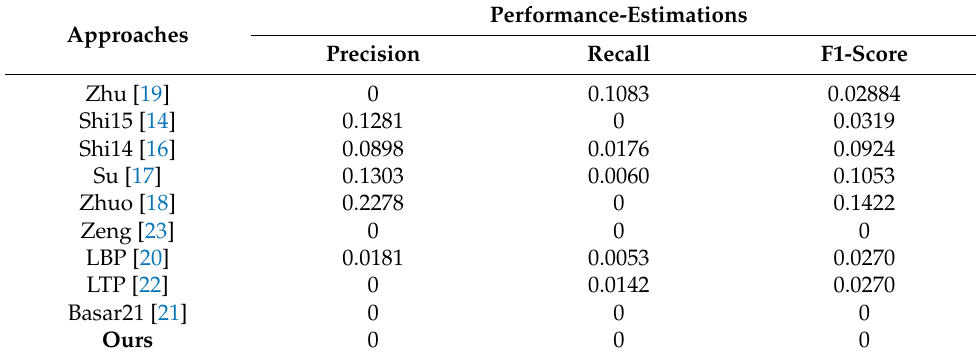
Performance-Estimations